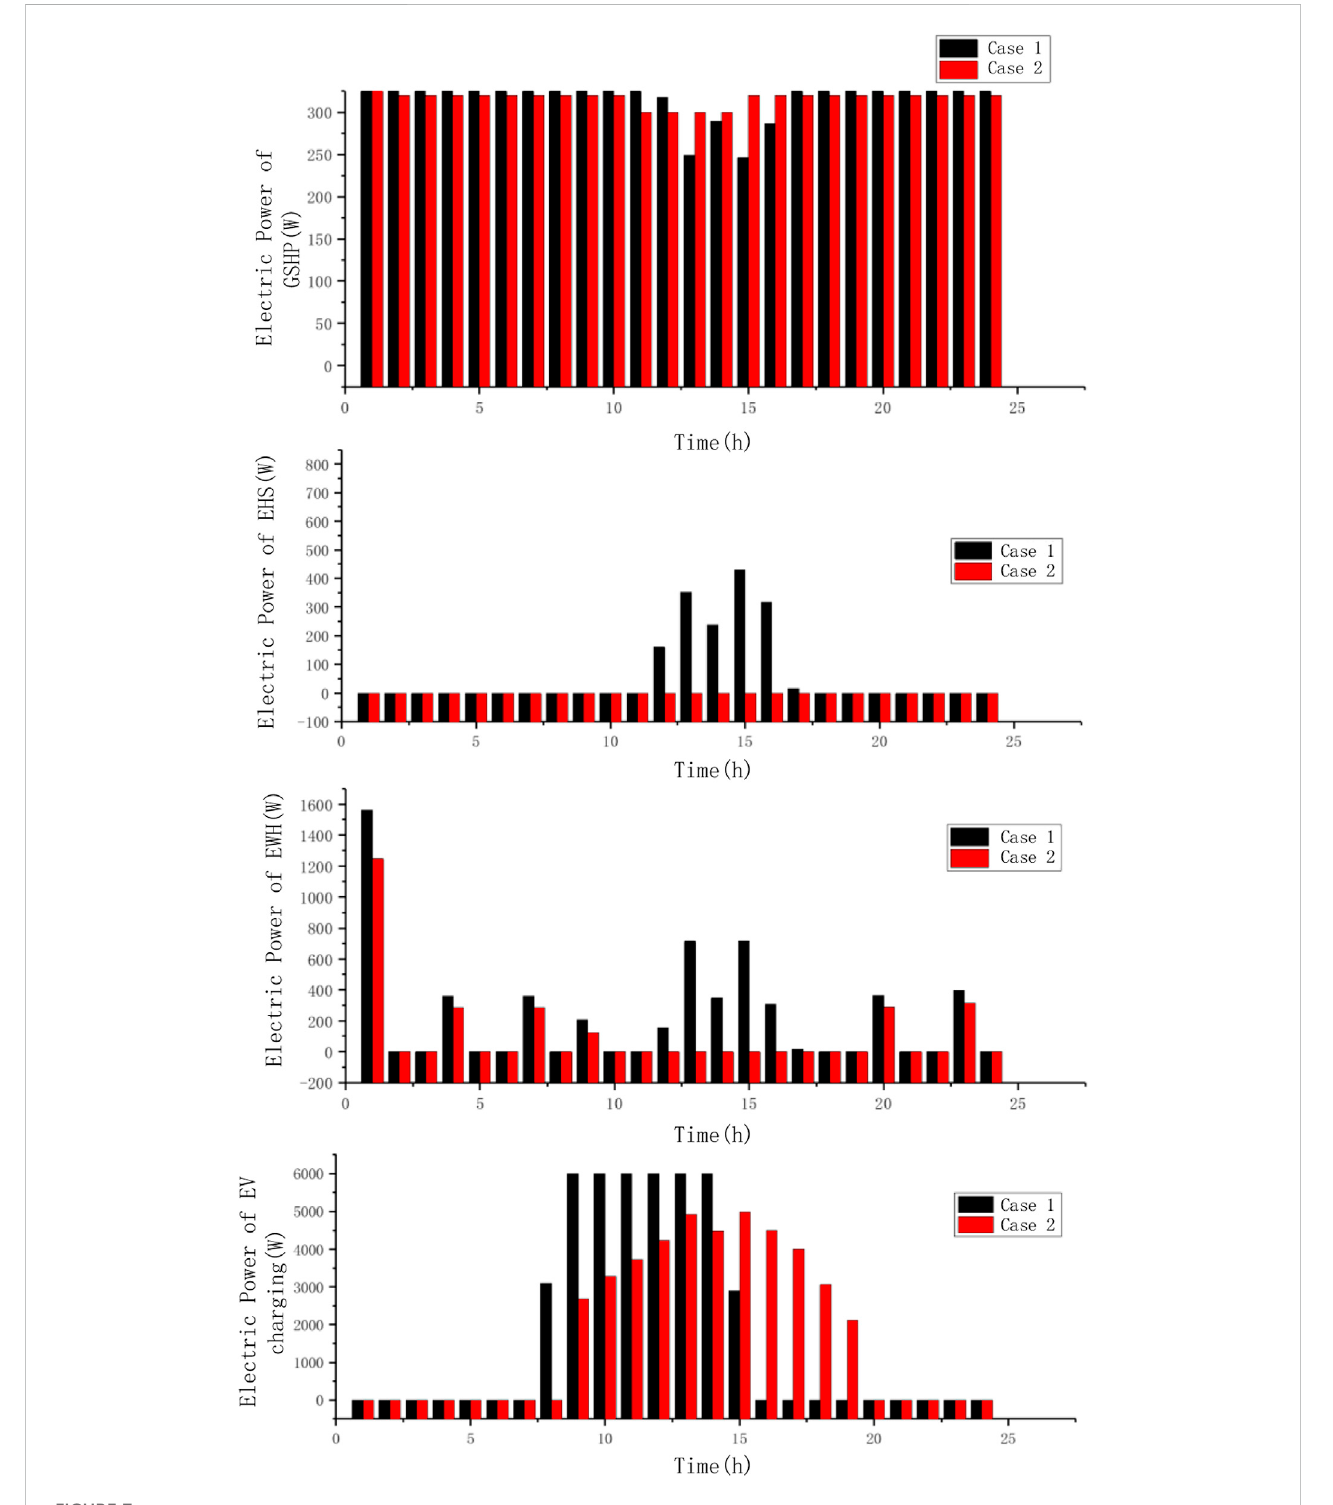
FIGURE 7 Dispatching and operation of MEHLs in two cases in the DA